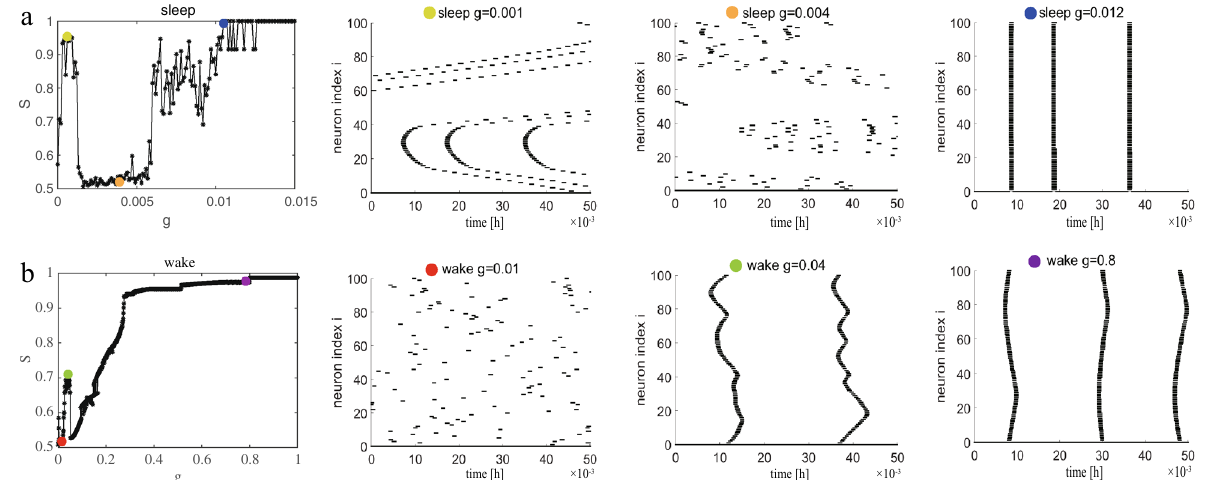
Figure 2. Synchronization diagrams of the coupled neurons in ring-shaped regular network with ( k = 4 ) during sleep and wake. ( a ) The global order parameter S and corresponding raster plots during sleep. ( b ) The global order parameter S and corresponding raster plots during when g is increased further as the perspective of raster plots is the same in quality from g = 0.04 to g = 1.00 . We cannot increase g to arbitrary large values, as after a certain value (near g ≃ 1.00 ) neurons start subthreshold oscillations without spike generation 50 . We therefore conclude that neurons in ring-shaped network with purely local interactions lead to local order. Moreover, when the neural network has no random long-range connec- tions, the network can finally achieve synchronization with the increase of g during sleep but not during wake. A Comparison between Figs. 1 and 2 shows that both the synchronization diagrams ( S − g ) and the raster plots are different. It might have been inferred that the structure of the homogeneous lattice network ( k = 4 ) in Fig. 1, the way neurons are connected, would lead to a different synchronization transition pattern from that of homogeneous ring-shaped network ( k = 4 ), that is to say the influence of the long-range connections may change this phenomena. According to the results associated with Figs. 1 and 2, we can draw the following conclusions: (1) The type and shape of transition curves ( S / R − g plots) are different between sleep and wake, which may be due to the